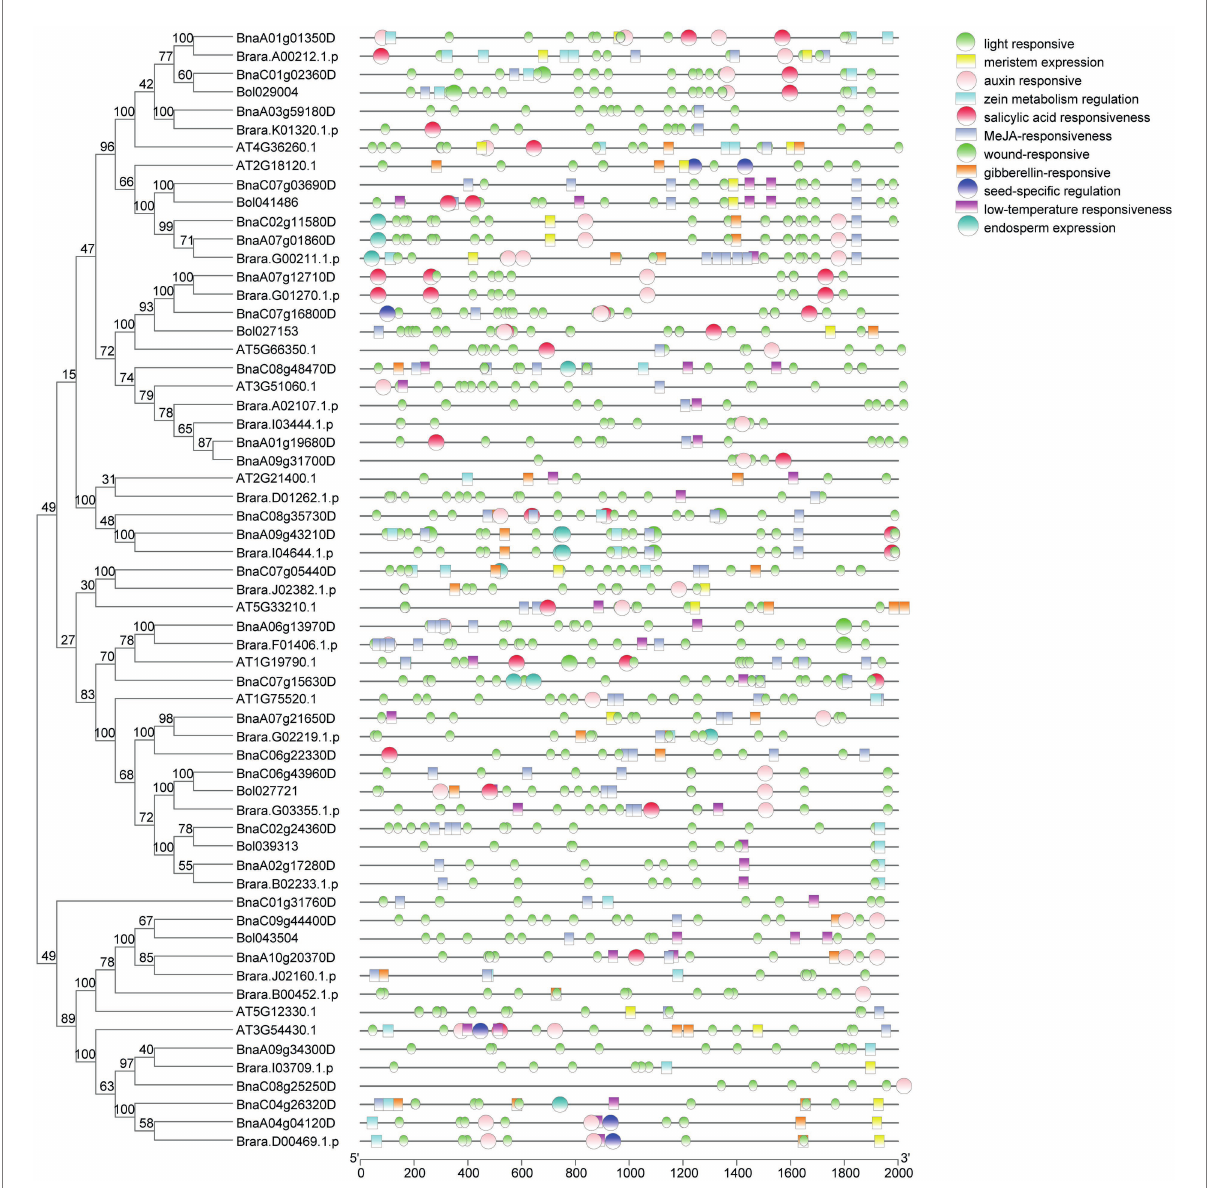
FIGURE 6 Cis -element analysis in the promoter regions of the SHI/STY genes. The PlantCARE software was used to determine the presence of different c is-acting elements. The different cis -elements were represented in different colored